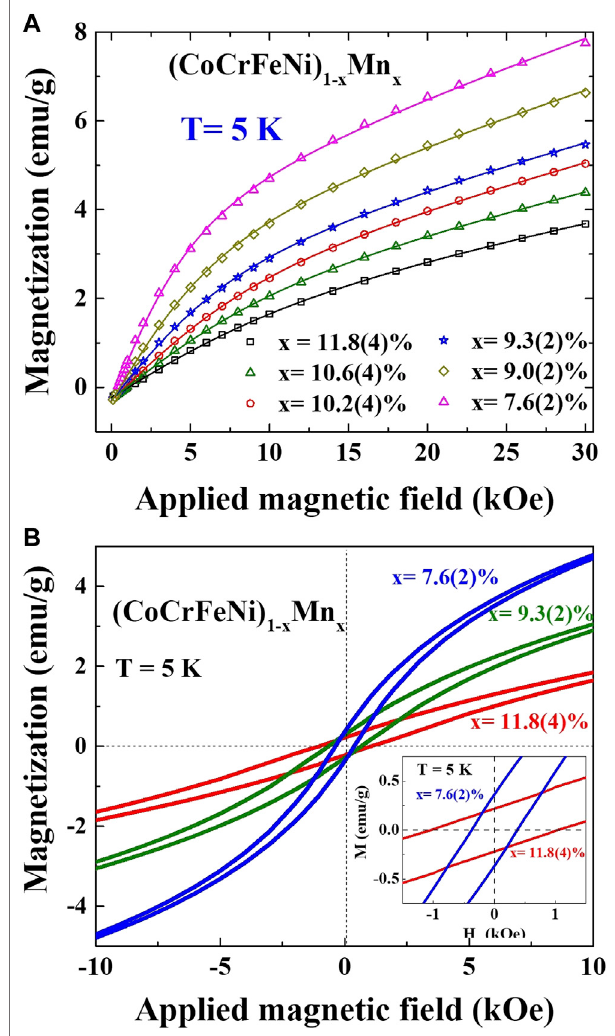
fi eld-increasing section of the M ( H ) curves of the (CoCrFeNi) 1 − x Mn x HEAs from x =7.6 – 11.8% at 5 K.Solidlines arethe fi tstoa Langevin function plus a χ ferri term. (B) The magnetic hysteresis of the (CoCrFeNi) 1 − x Mn x HEAs at three representative Mn contents x measured at 5 K. The inset in (B) shows a magni fi cation of the coercivity fi eld by increasing the Mn